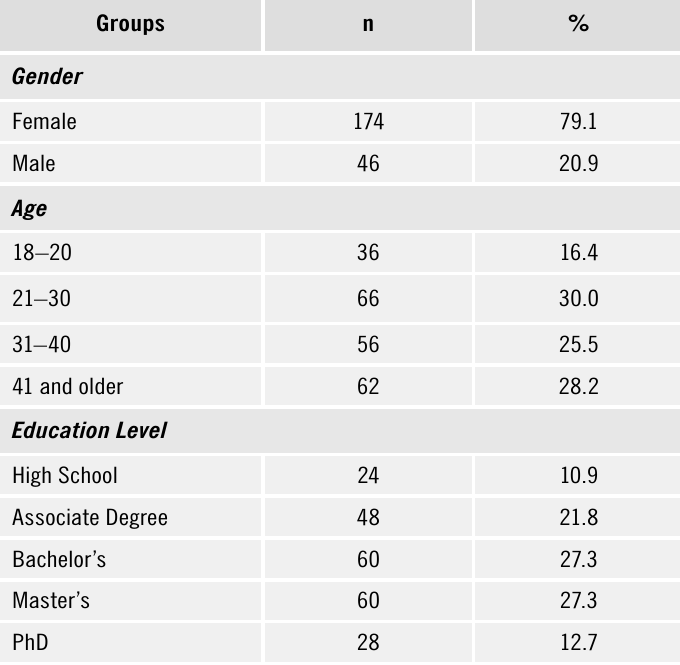
Table 1. Demographic characteristics of the participants Groups n